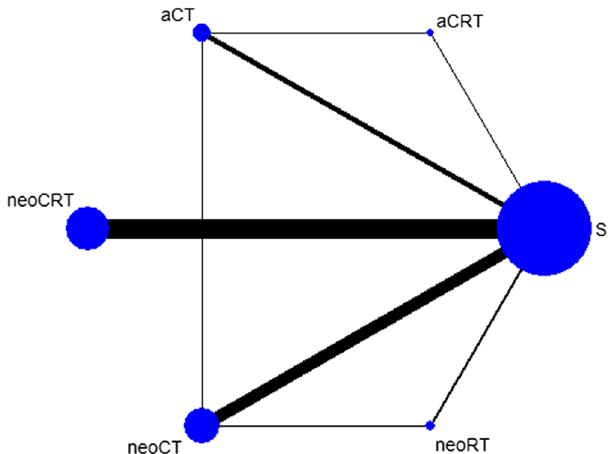
Figure 2. Network plot showing the different treatment modalities. neoCRT neoajuvant chemoradiotherapy, neoCT neoajuvant chemotherapy, neoRT neoajuvant radiotherapy, aCRT adjuvant chemoradiotherapy (CRT), aCT ajuvant chemotherapy, S surgery alone.